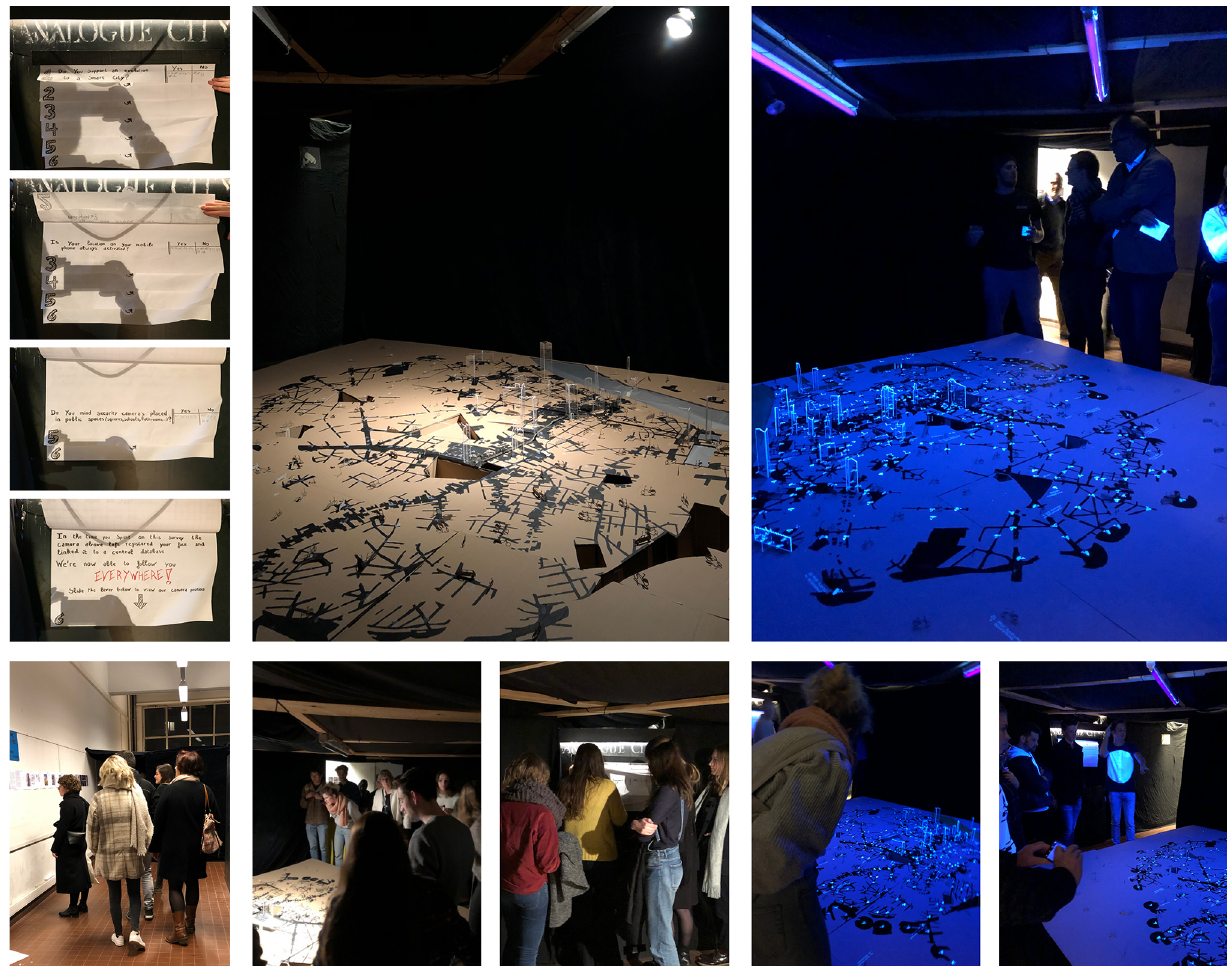
Figure 7. Exhibition at the last day of the workshop: An introduction of the explorations, leading towards a dark room that contained the ‘Analogue City’ map, that showed another image when the UV-lights were turned on (pictures to the right) in reaction to an ‘analogue quiz.’ Source: The ‘Analogue City,’ IDW University of Antwerp 2019 students, and the